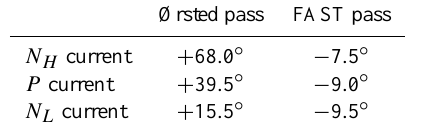
Figure 6 Table 1. Angle between the directions of the magnetic East and of the 3 current sheets associated with the arc, along the Ørsted and FAST orbits. The angles are positive clockwise Ørsted pass FAST pass N H current + 68 . 0 ◦ − 7 . 5